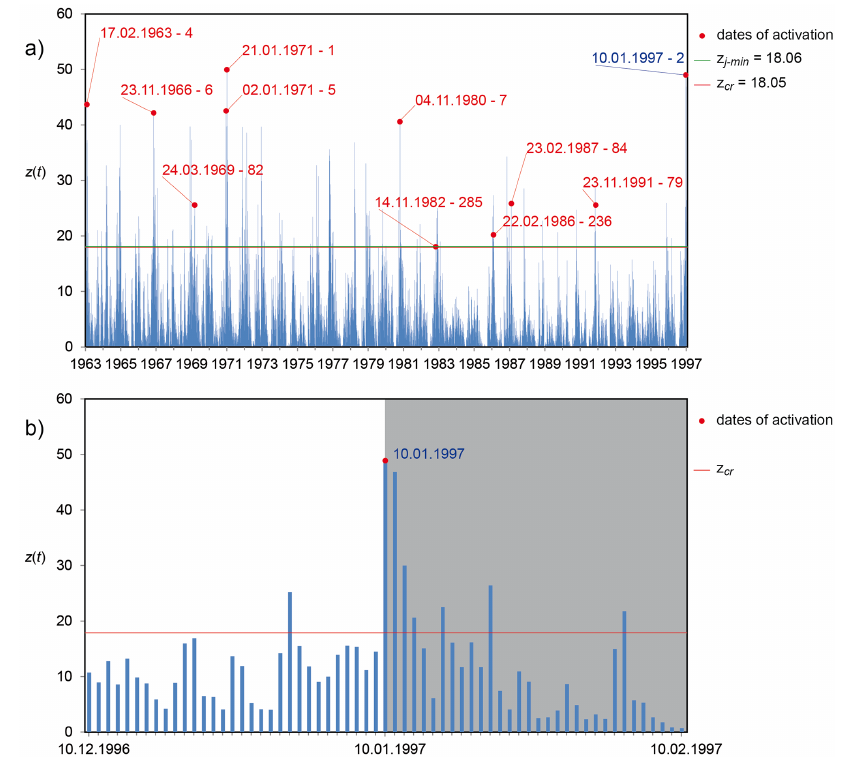
Figure 13. Sorrento Peninsula case study. (a) Validation of the average kernel against the no. 11 event. (b) Particular of (a) , limited to the period ± t b , including the date of validation. Key as in Fig. 11. The blue label indicates the date of validation. Grey background marks the period after the event that may be employed for re-calibration.